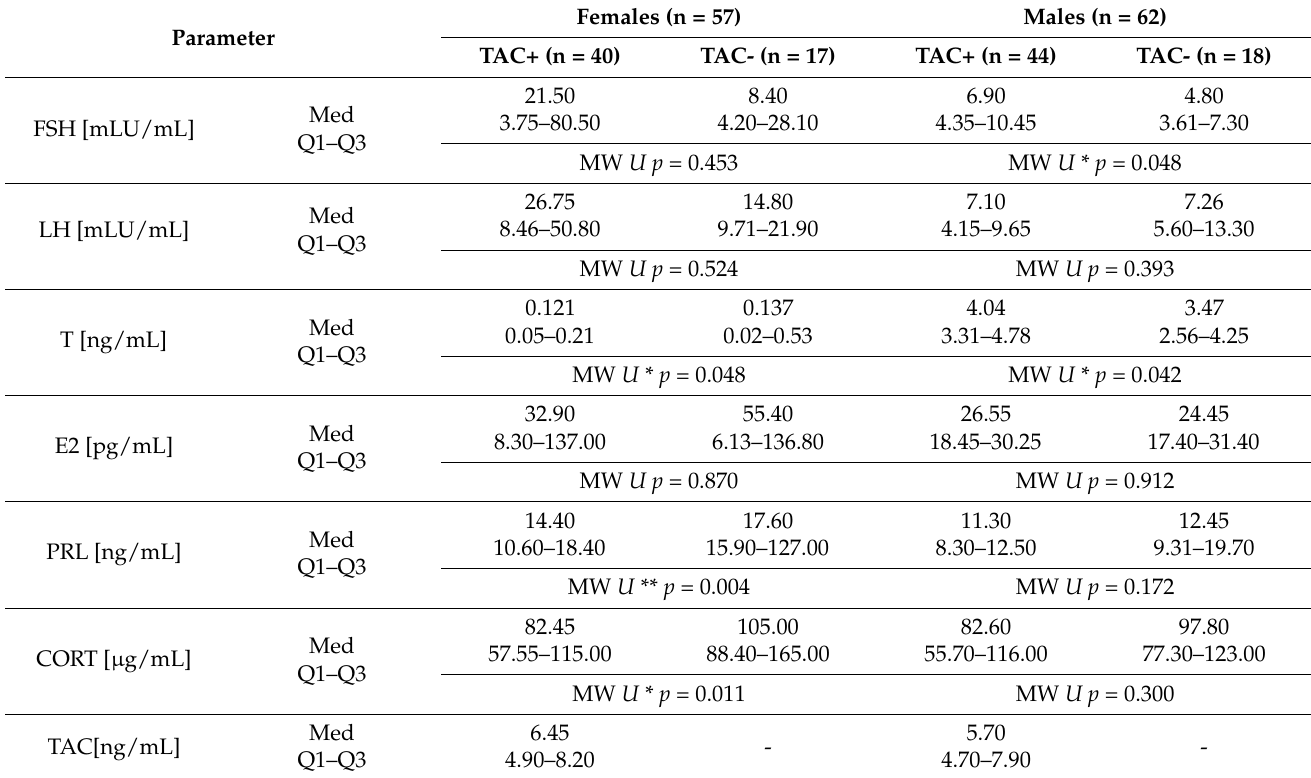
Table 3. Hormones and TAC concentrations in blood of female and male renal transplant recipients. Parameter